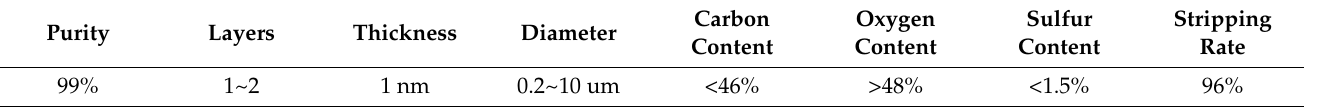
Table 2. Material parameters of